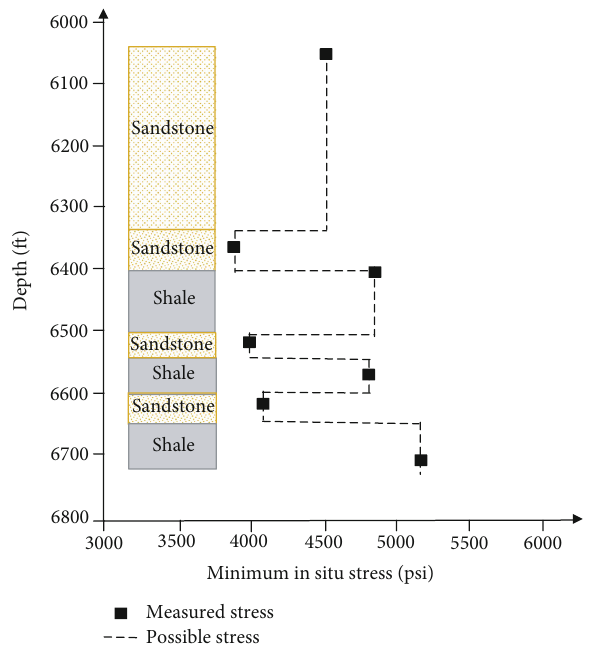
Figure 4: The minimum horizontal stress obtained in overcoring measurements from openhole hydraulic fracture tests in the Canyon Sands of West Texas (modi fi ed from [13]). The unit conversions are 1 psi = 0 : 00689 MPa and 1 ft : = 0 : 305m